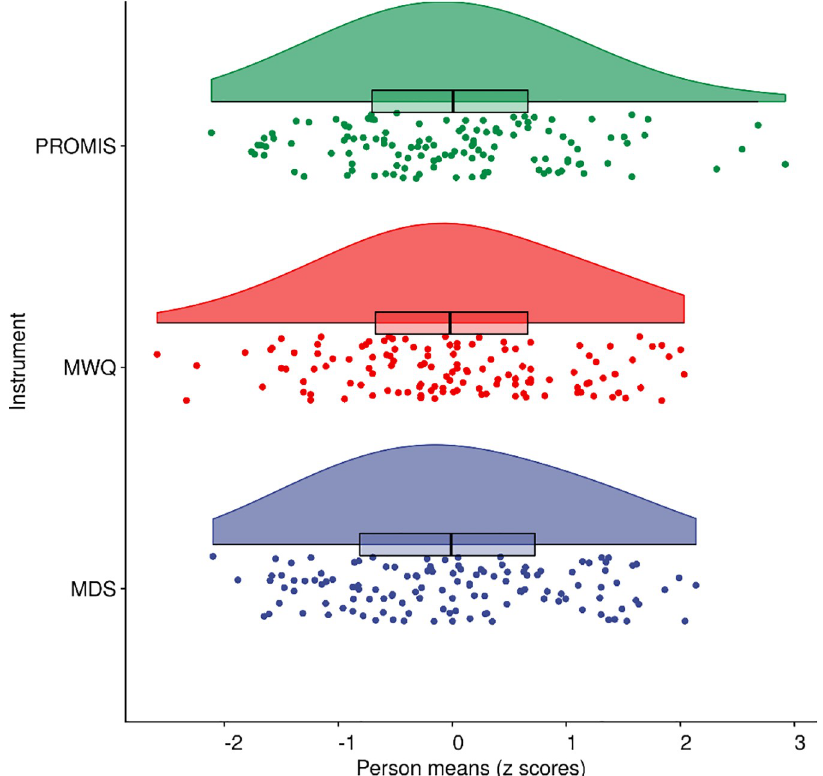
Fig 1. Raincloud plot of person mean scores ( z ) for each instrument administered across eight days. (MDS = Maladaptive daydreaming scale; MWQ = Mind wandering questionnaire; PROMIS = Patient-reported outcomes measurement information system–Sleep disturbances short form). Each dot shows the observed person mean score for that instrument (jittered). The lower and upper hinges on the boxplots represent the first and third quartile with the median in between, whereas the whisker lines extend to the most extreme values but no further than 1.5 × the interquartile range from the hinge. The raincloud shapes illustrate the shapes of the distributions based on Kernel density probability functions (scaled to have equal heights across